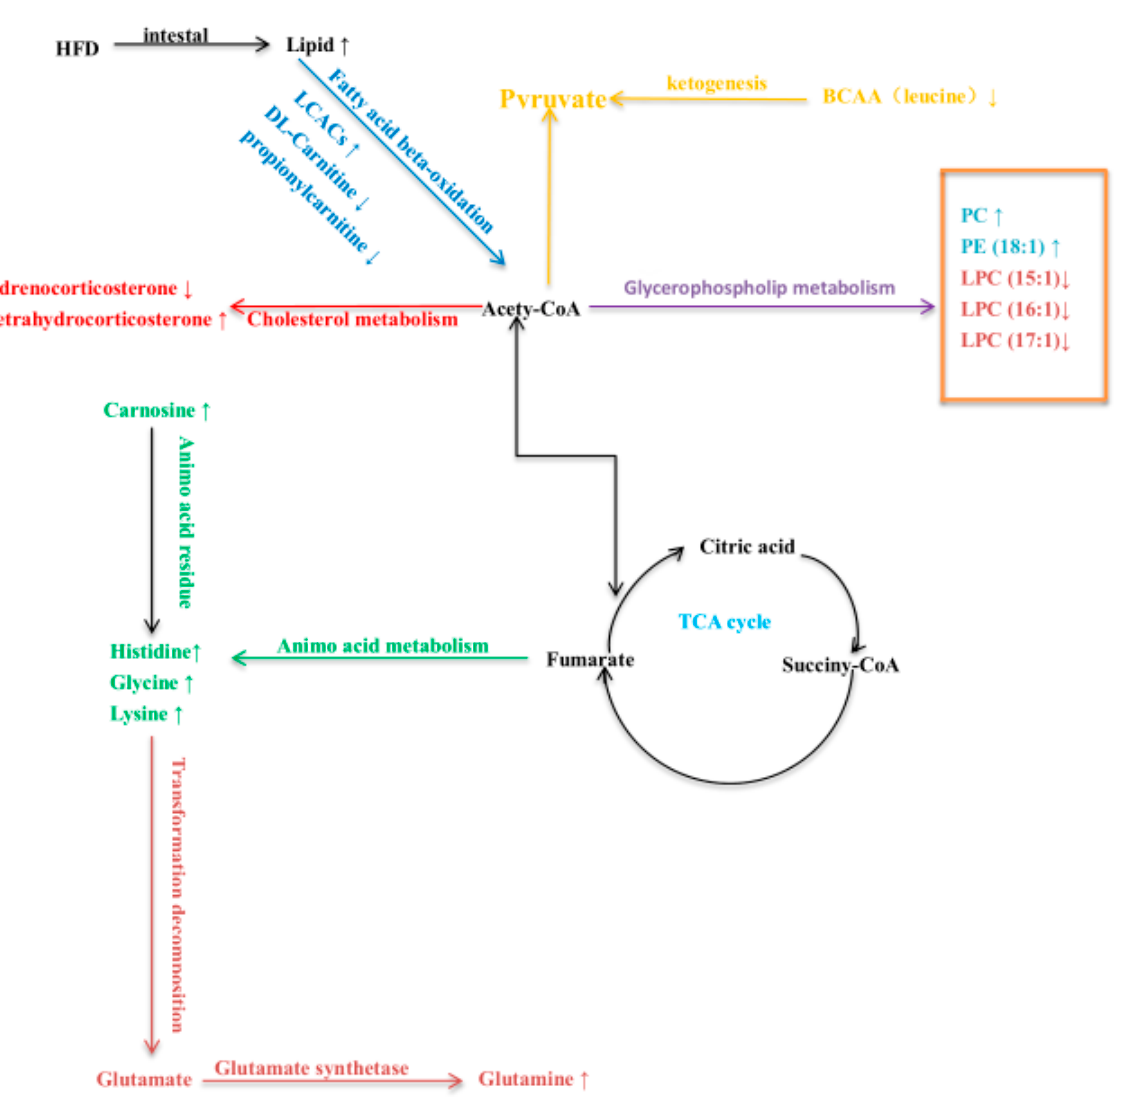
Figure 3. Interference and change of potential metabolic pathways in skeletal muscle of rabbits fed a high-fat diet. Different colors represent different metabolic pathways.